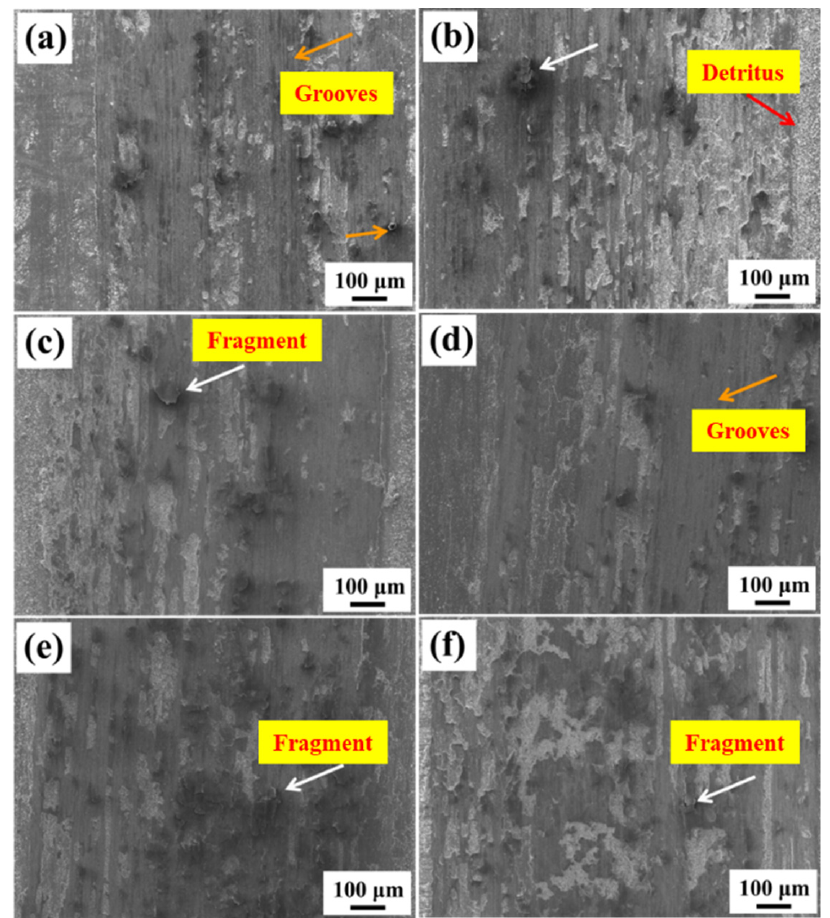
Figure 7. SEM images of the morphology of the wear surface of 17-4PH high-strength steel formed by SLM. ( a ) SLM-formed sample; ( b ) sample heated-treated in solution at 940 °C; ( c ) sample heated- treated in solution at 990 °C; ( d ) sample heated-treated in solution at 1040 °C; ( e ) sample heated- treated in solution at 1090 °C; ( f ) sample heated-treated in solution at 1140 °C.